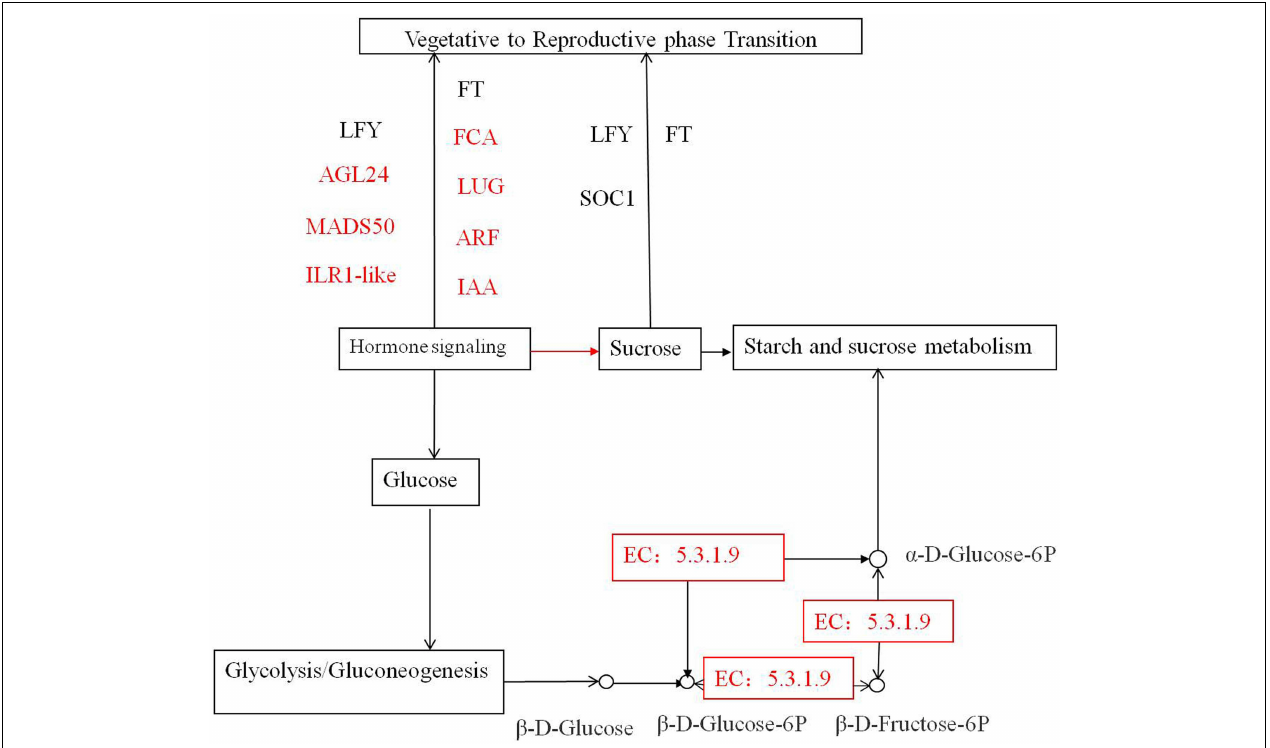
FIGURE 7 | Multiple interactions among the genes involved in vegetative to reproductive phase transition and pathways of starch and sucrose metabolism and glycolysis/gluconeogenesis in response to hormone signaling. Colored rectangles correspond with the Matesequoia genes detected using